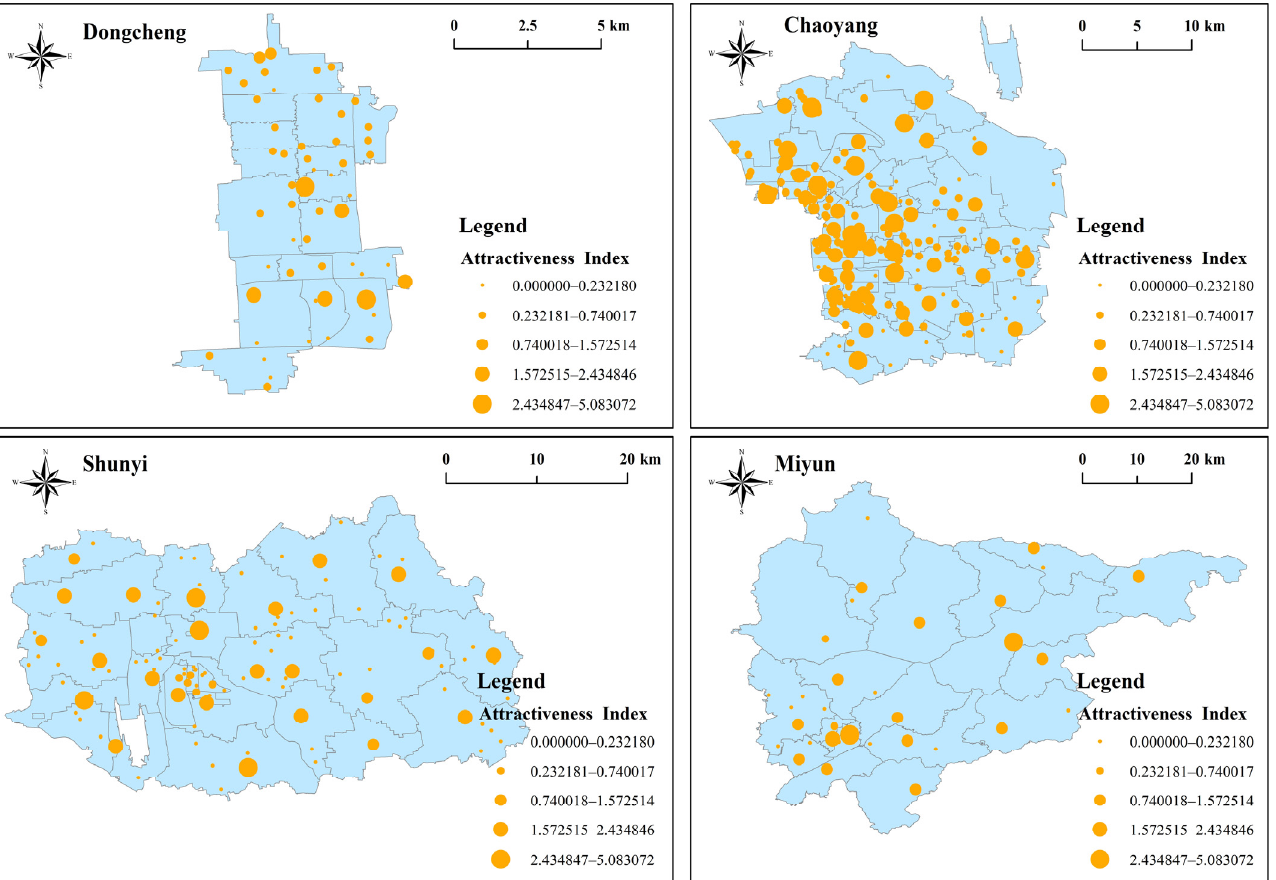
Figure 4. Attractiveness index of community hospitals within walking distance of four districts.